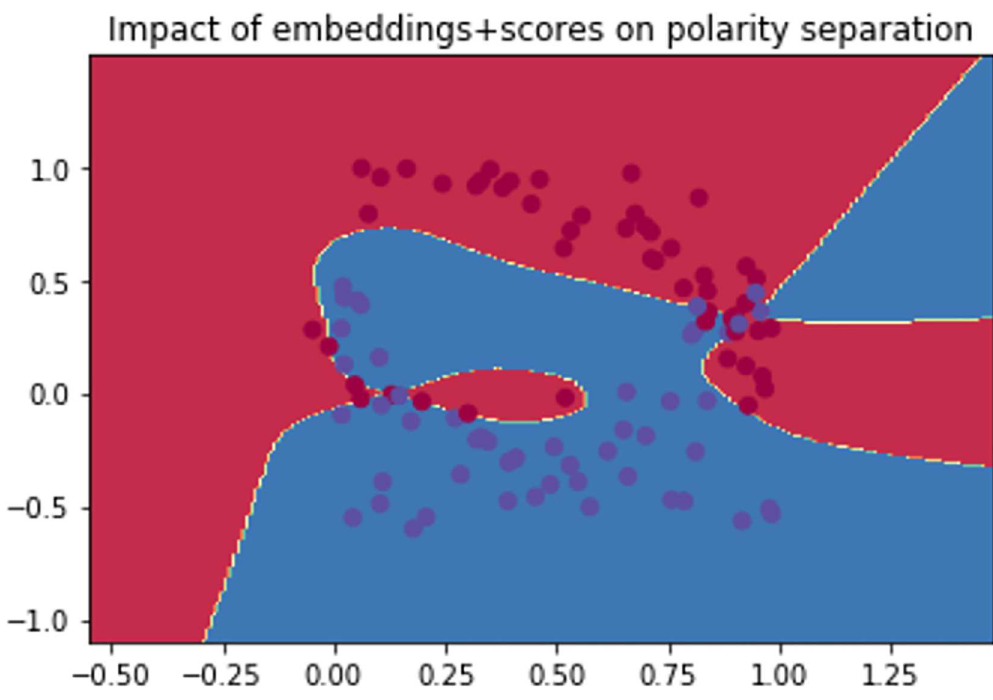
Fig 33. Impact of edge embedding and path scoring on the decision